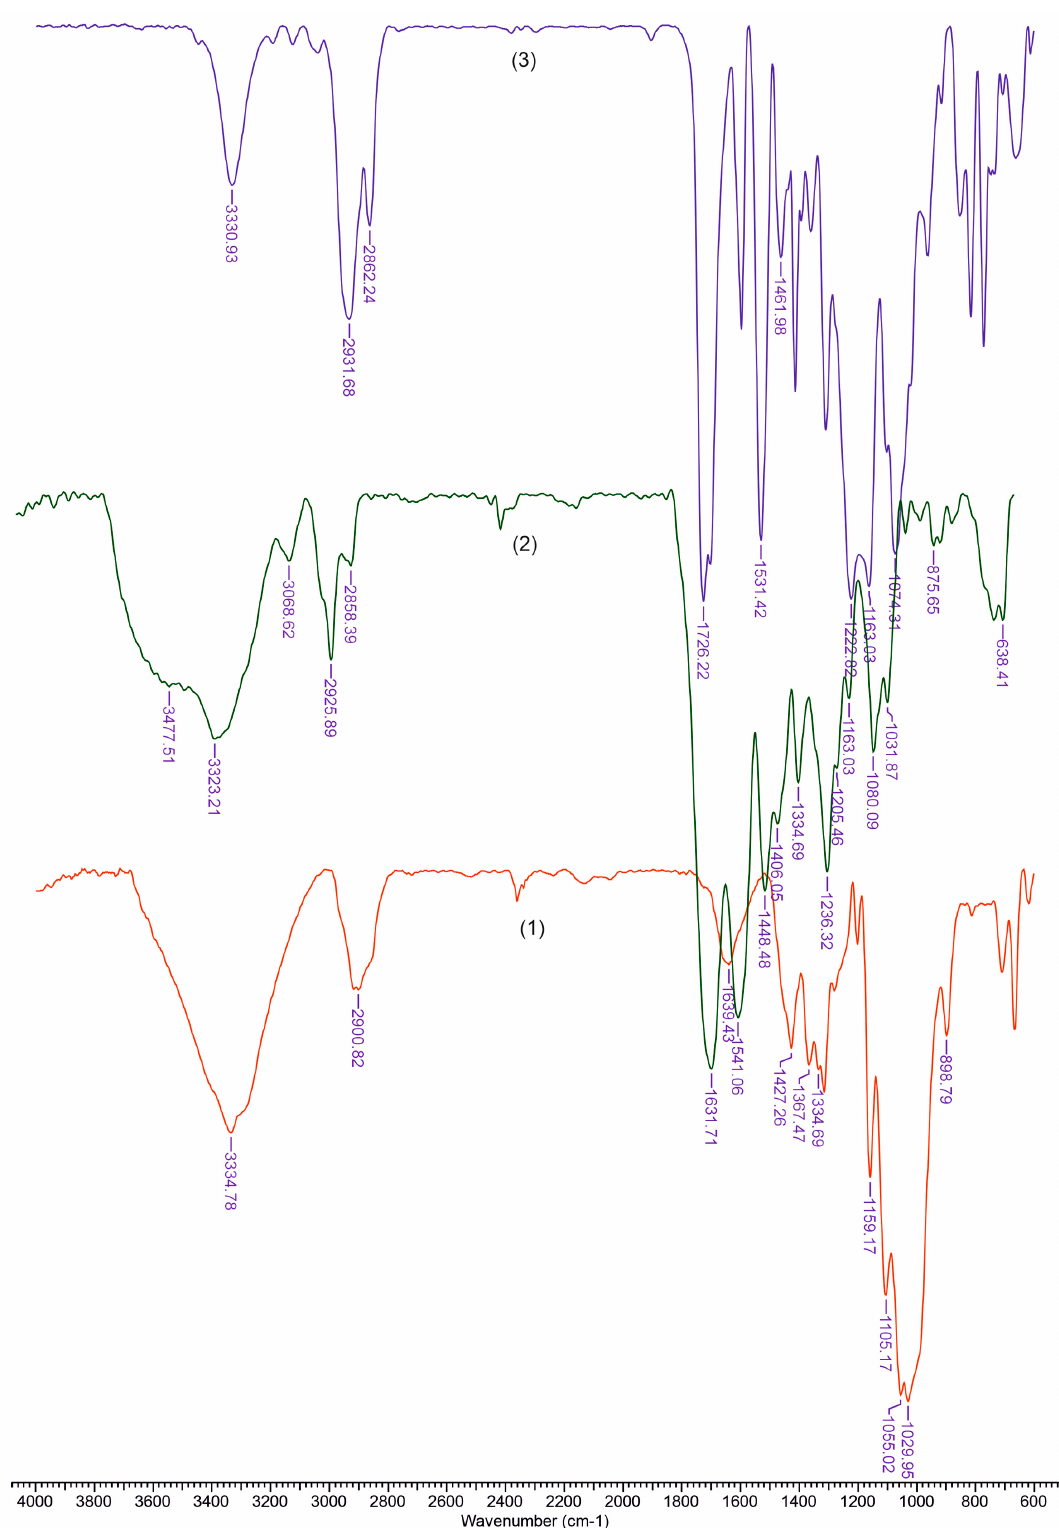
Figure 2. FTIR spectra of reference’ components: ( 1 )—cellulose; ( 2 )—polyurethane; ( 3 )—collagen.